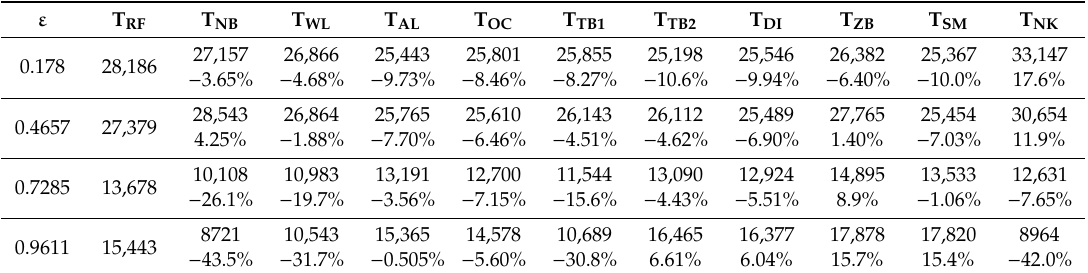
Table 3. Random fatigue life estimation